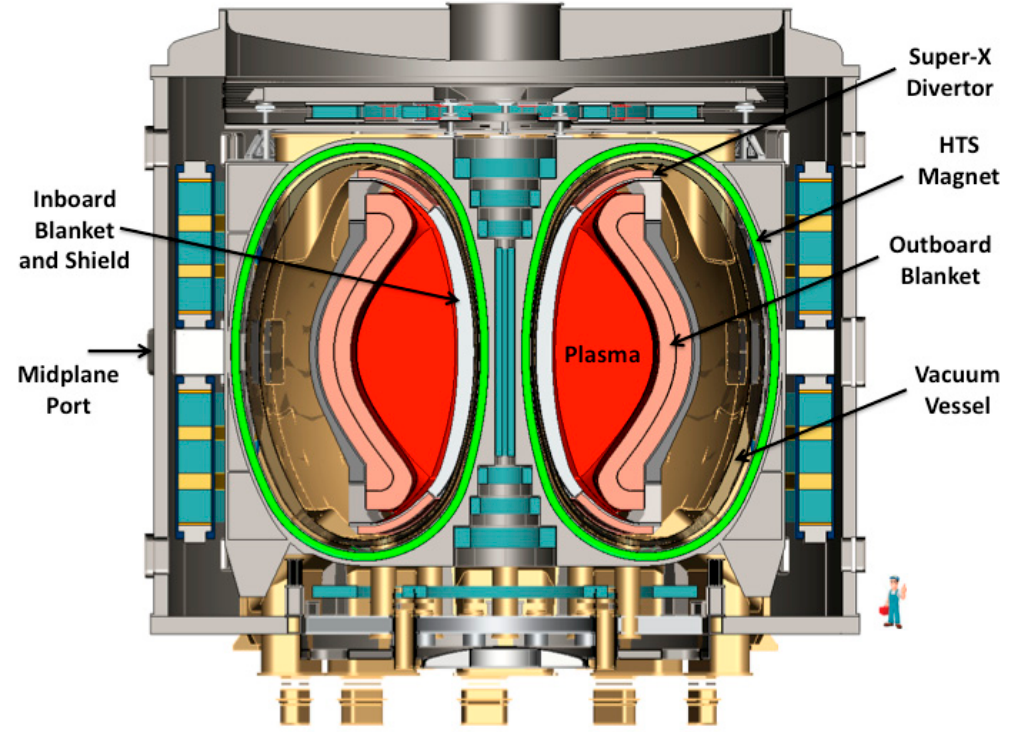
Figure 2. CAD Drawing of the Fusion Nuclear Science Facility with high-temperature superconducting (HTS) magnets, displaying the fusion power core, HTS magnets, and maintenance port.